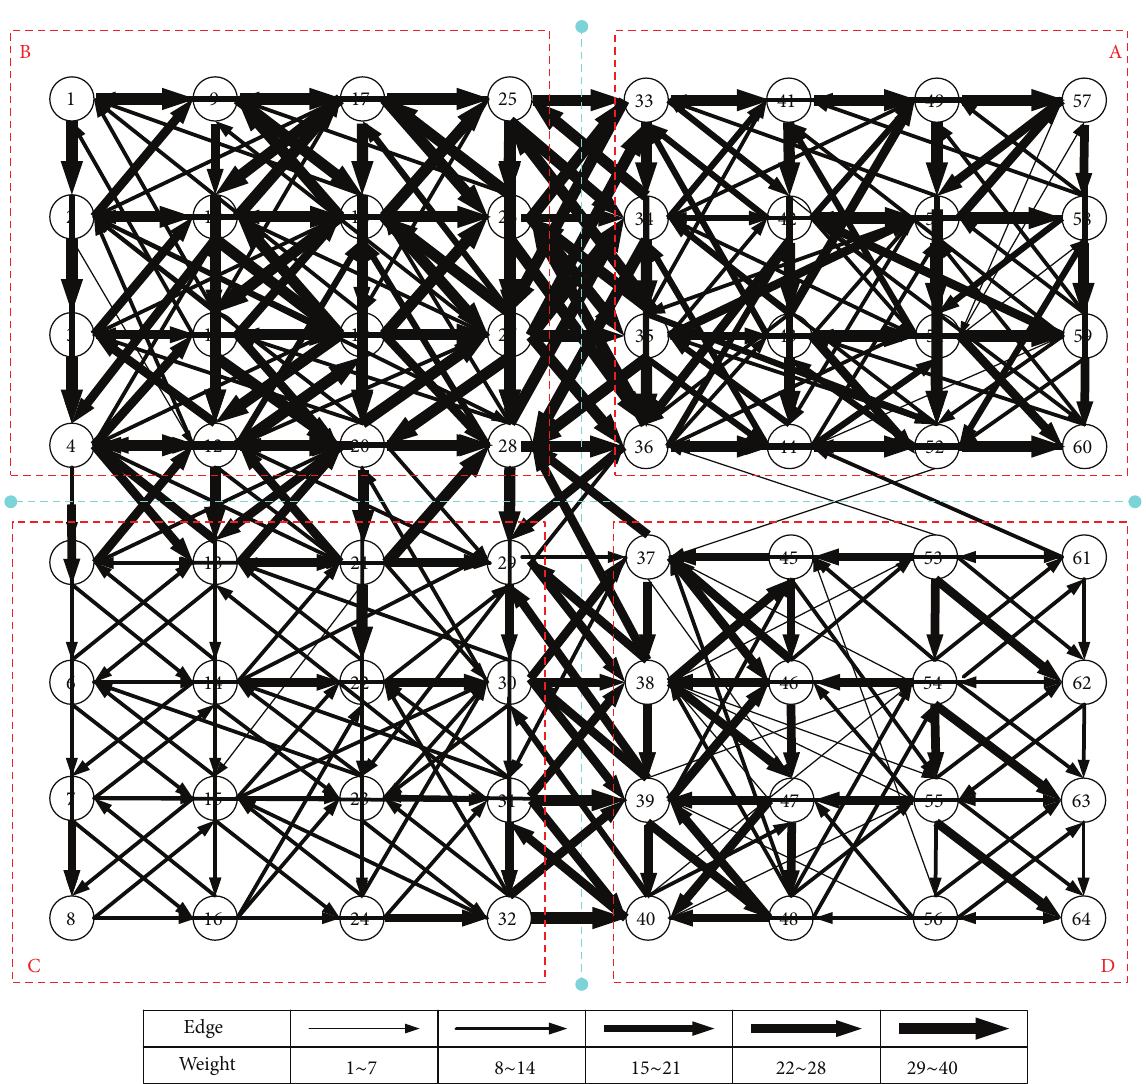
Figure 5: Traffic state pattern transition relation network (TSPTRN) of Shenzhen’s Nanshan District.